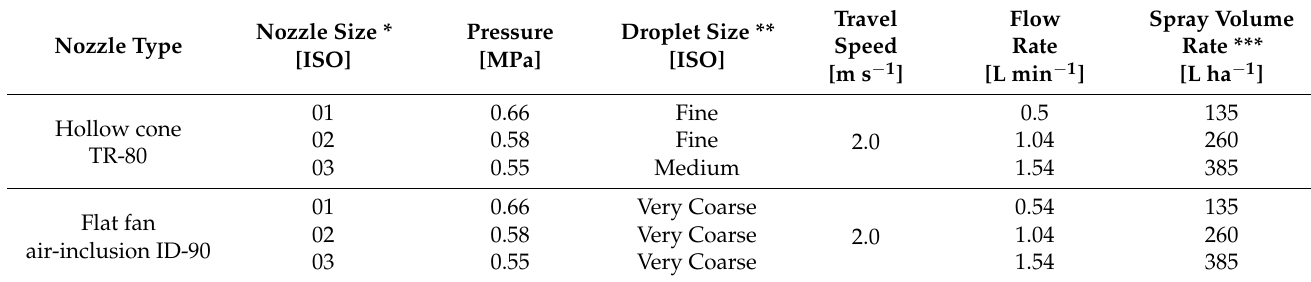
Figure 1. The layout of the experimental stand: ( A ) experimental scheme, ( B ) cross-flow sprayer (Holder GmbH, Metzingen, Germany), ( C ) apple leaves of Jonagold cv. as spray collectors, ( D ) spray coverage on apple leaf produced by flat fan air-inclusion nozzle (example). Table 2. Parameters of adjuvants’ application on apple leaves.